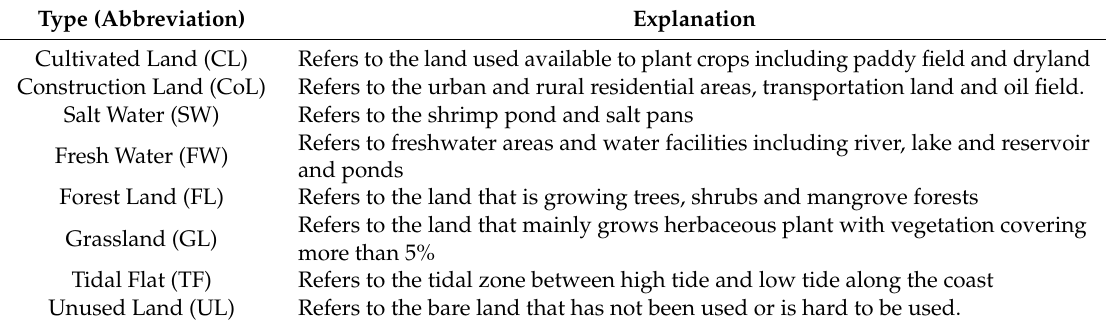
Table 2. The land use classification system based on